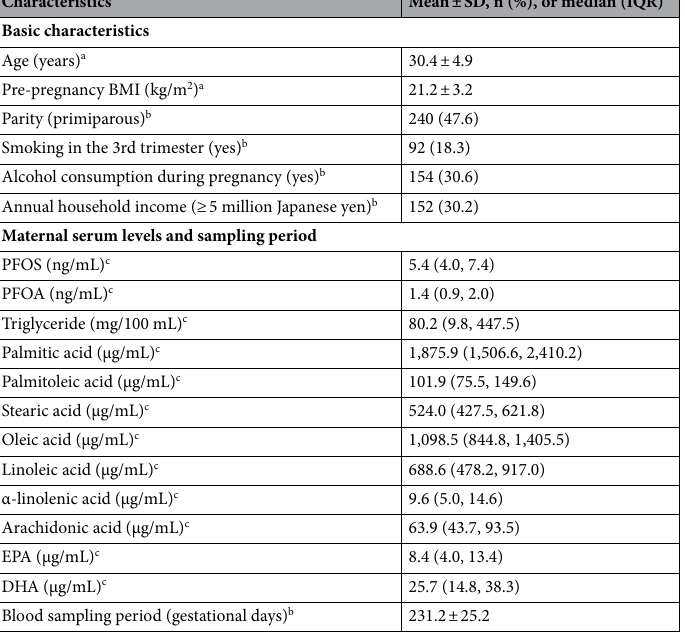
Table 1. Maternal characteristics (n = 504). BMI, body mass index; DHA, docosahexaenoic acid; EPA, eicosapentaenoic acid; IQR, inter-quartile range; PFOS, perfluorooctanesulfonate; PFOA, perfluorooctanoate; SD, standard deviation. a Mean ± SD. b n (%). c Median